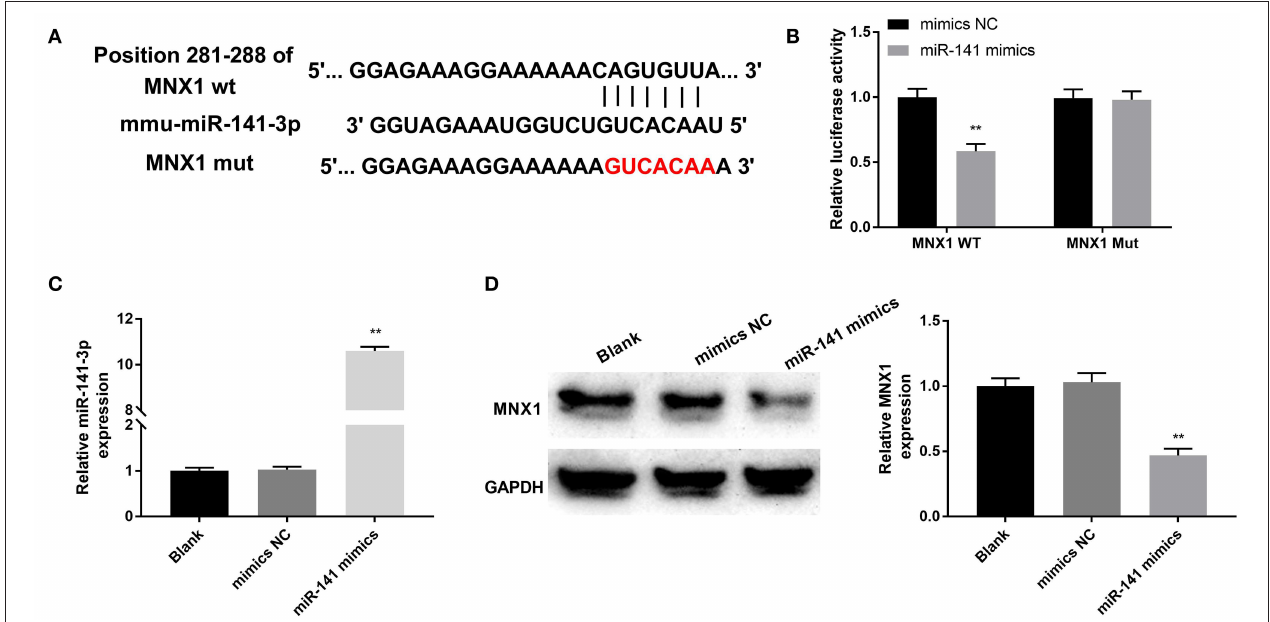
FIGURE 4 | MNX1 was a newfound target of miR-141-3p. (A) The sequence relation between miR-141-3p and MNX1 was predicated via Starbase software; (B) the luciferase activity was appraised via dual luciferase reporter system; after miR-141 mimics and miR-141 NC vectors transfection, (C) the transfection efficiency of miR-141-3p was monitored via RT-qPCR; (D) protein level of MNX1 was determined via Western blot assay. ** P < 0.01 in comparison with the Blank